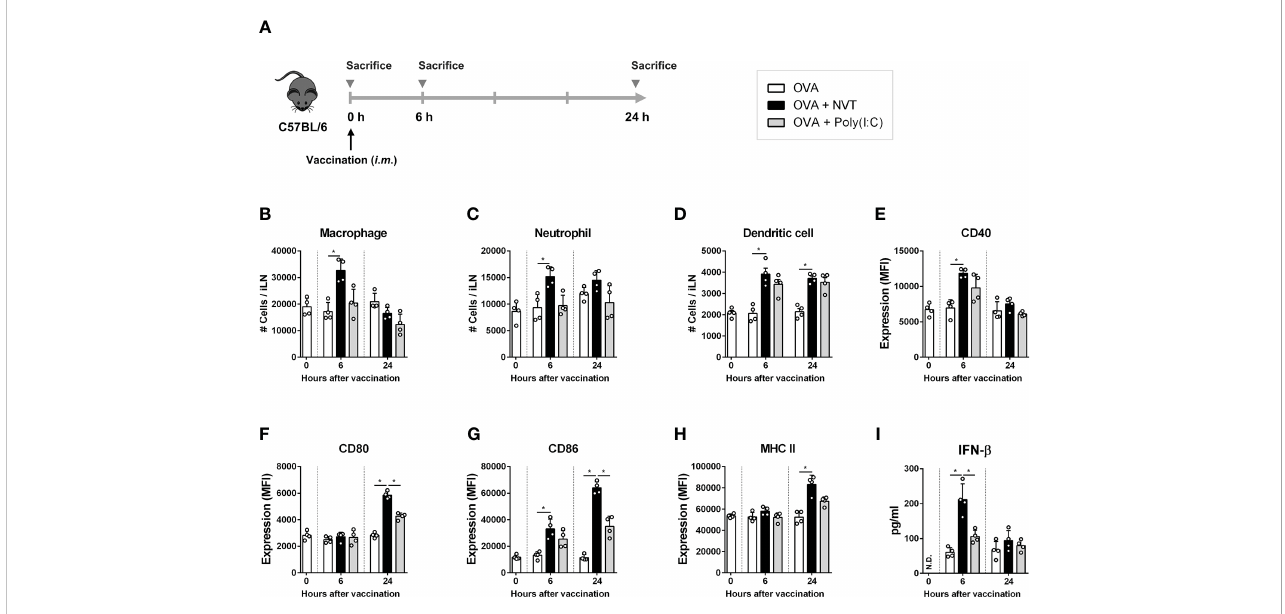
FIGURE 3 NVT prompts innate immune responses. (A) Experimental scheme. C57BL/6 female mice (n=4 per group) were injected into the thigh muscles of the right hind leg with OVA (2 m g) either alone or together with NVT (10 m g) or poly(I:C) (10 m g). At 0, 6 and 24 h, draining inguinal lymph node (iLN) on the right hind leg was collected, dissociated into single cells, and whole cells were counted. (B-D) Macrophages (CD11b + F4/80 + ), neutrophils (CD11b + Ly6G + ) and DCs (CD11c hi MHC-II hi ) were analyzed by fl ow cytometry, and the absolute numbers were calculated by multiplying the total iLN cells by their percentage. (E-H) The mean fl uorescence intensity of CD40, CD80, CD86, and MHC-II expression on CD11c hi MHC-II hi DCs was determined by fl ow cytometric analysis. (I) The concentration of IFN- b in serum was measured by ELISA. All data were expressed as the mean values ± S.D. *, P < 0.05; N.D., not